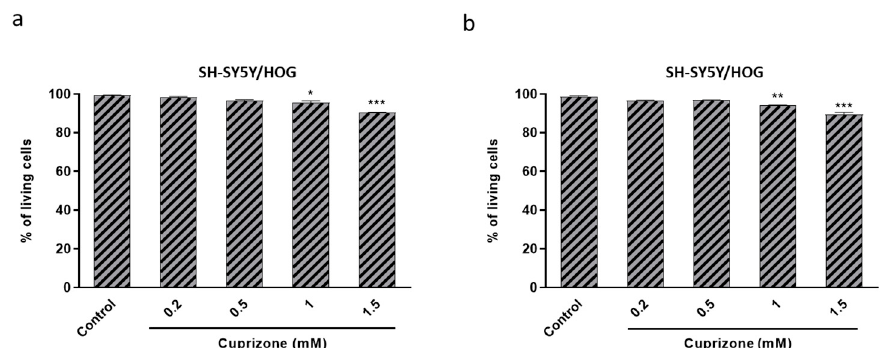
Figure 6. The number of SH-SY5Y and HOG living cells in the co-culture was calculated after treatment with increasing concentrations of CPZ (0.2–1.5 mM) for 24 ( a ) and 48 h ( b ). Cell viability is represented as the percentage of living cells versus control. Data are the mean ± S.E.M of three independent experiments. Each experimental group was run in triplicate, and each plate was counted at least three times. Significant differences were analyzed by a one-way ANOVA followed by post-hoc Tukey’s test. * p < 0.05, ** p < 0.01, *** p < 0.001 compared to control.